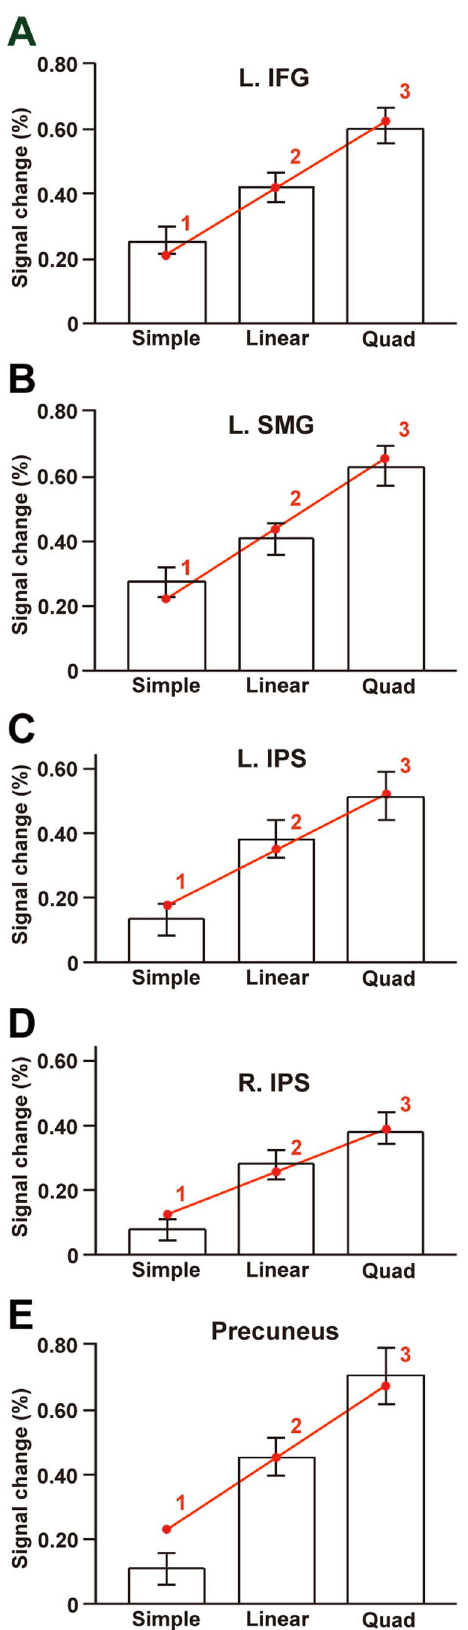
Figure 4. Quantified activations modulated by the DoM in the hierarchical tree structures. The percent signal changes in the L. IFG (A) and L. SMG (B) were taken from the local maxima in Simple – Match (circled in yellow in Figure 3C), whereas those in the L. IPS (C), R. IPS (D), and precuneus (E) were taken from the local maxima in Linear – Simple (circled in yellow in Figure 3D). Activations are shown for the Simple, Linear, and Quad conditions with reference to the Match task. Error bars indicate the standard error of the mean for the participants ( N =20). Overlaid red dots and lines denote the values fitted with the estimates (digits in red) for the DoM in the hierarchical tree structures (see Table